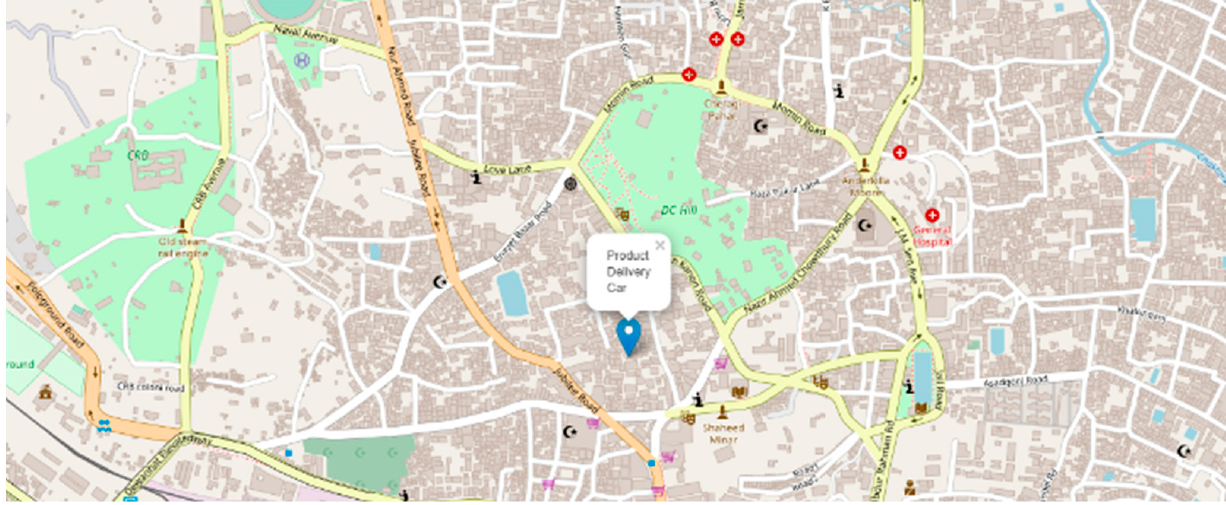
Figure 24. Map visualization of the geographical position of the car.